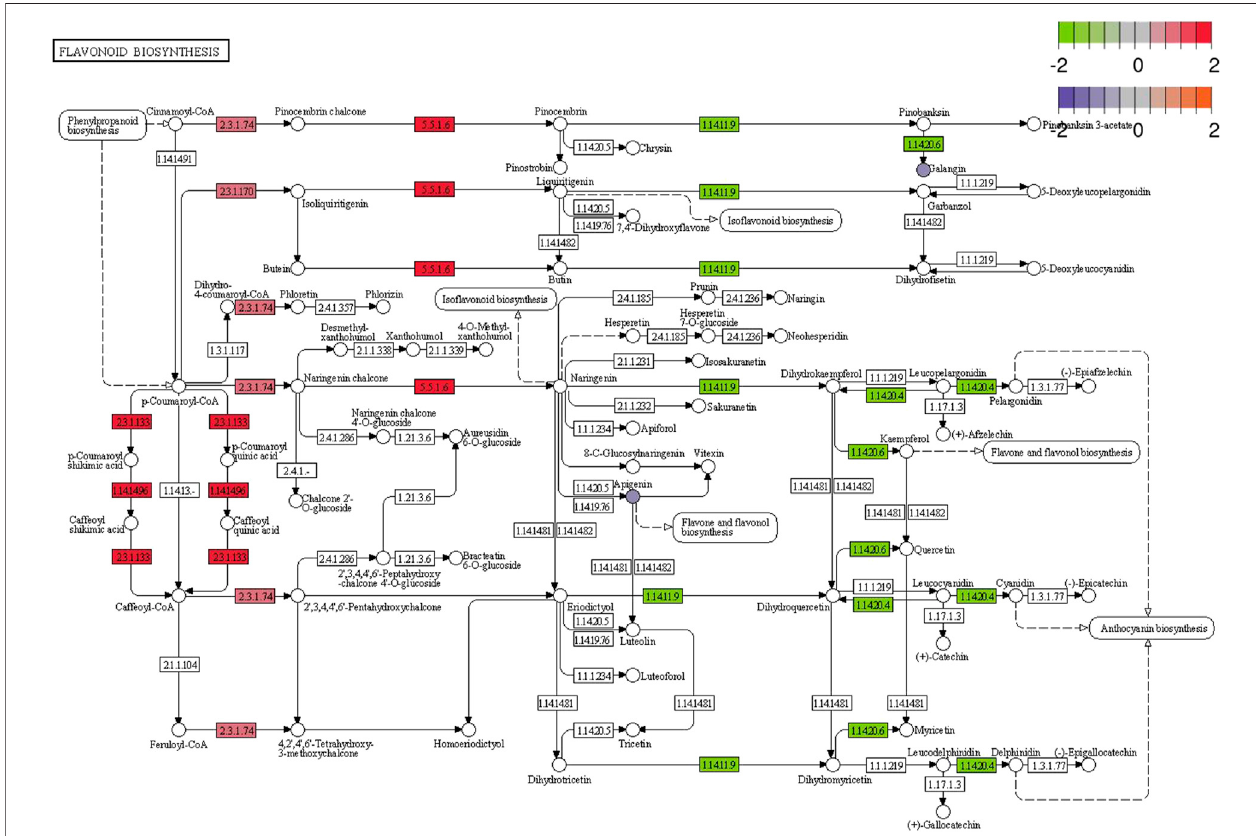
FIGURE14| Pathwayanalysisof fl avonoidbiosynthesispathwaysinsingle-headedrootsanddouble-headedroots.Theproposedmetabolicpathwaysarebased on the Kyoto Encyclopedia of Genes and Genomes (KEGG) database of metabolic pathways. The metabolites, written in circle, were detected in this study. Omitted metabolic processes are represented by dashed lines. The rectangle represent the genes. The red colors indicates upregulated expression and green colors indicates downregulated expression.